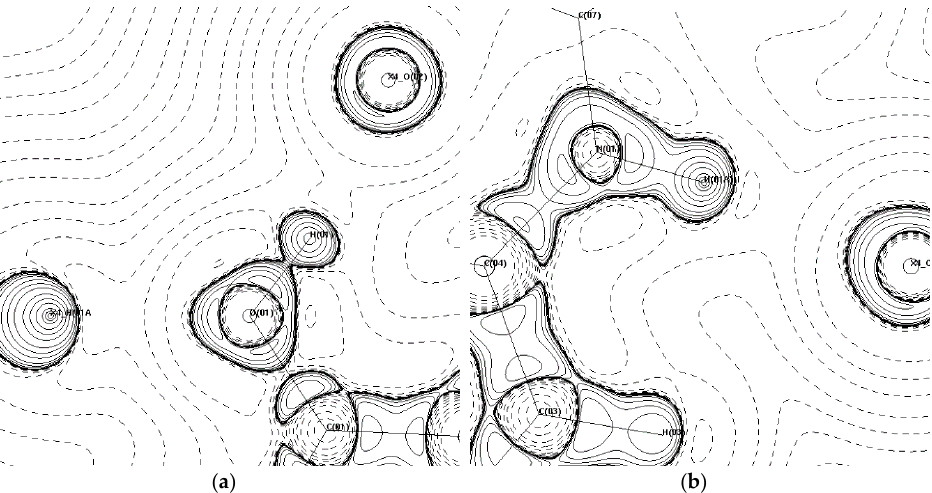
Figure 7. - ∇ 2 ρ bcp maps showing intermolecular hydrogen bonds that form the primary bonding motifs in ( 1 ) in the ( a ) C(01)-O(01)-H(01) plane and ( b ) H(03)–N(01)-H(01A) plane. Contour lines are plotted on a log scale. Solid lines indicate positive contours, and dashed lines indicate negative contours.